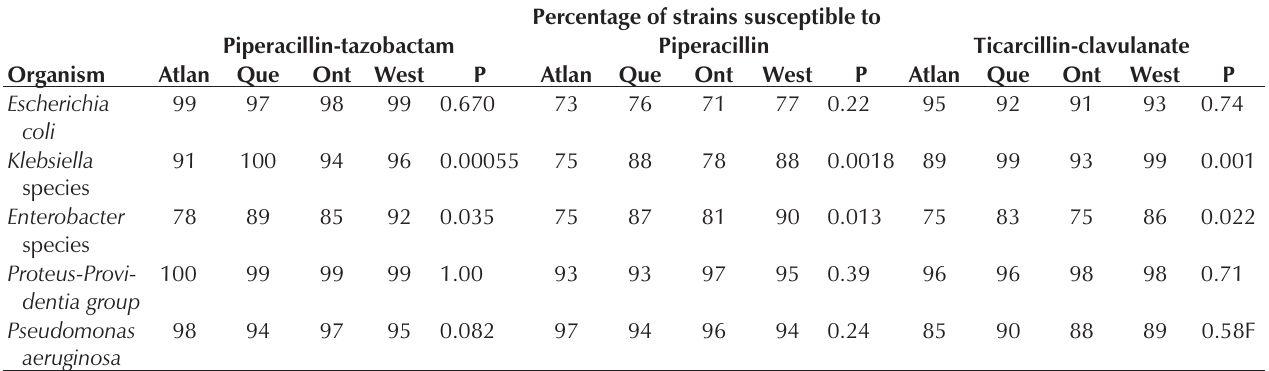
Comparative activity of piperacillin-tazobactam and other parenterally administered antibiotics against aerobic Gram-negative bacilli isolated in four Canadian